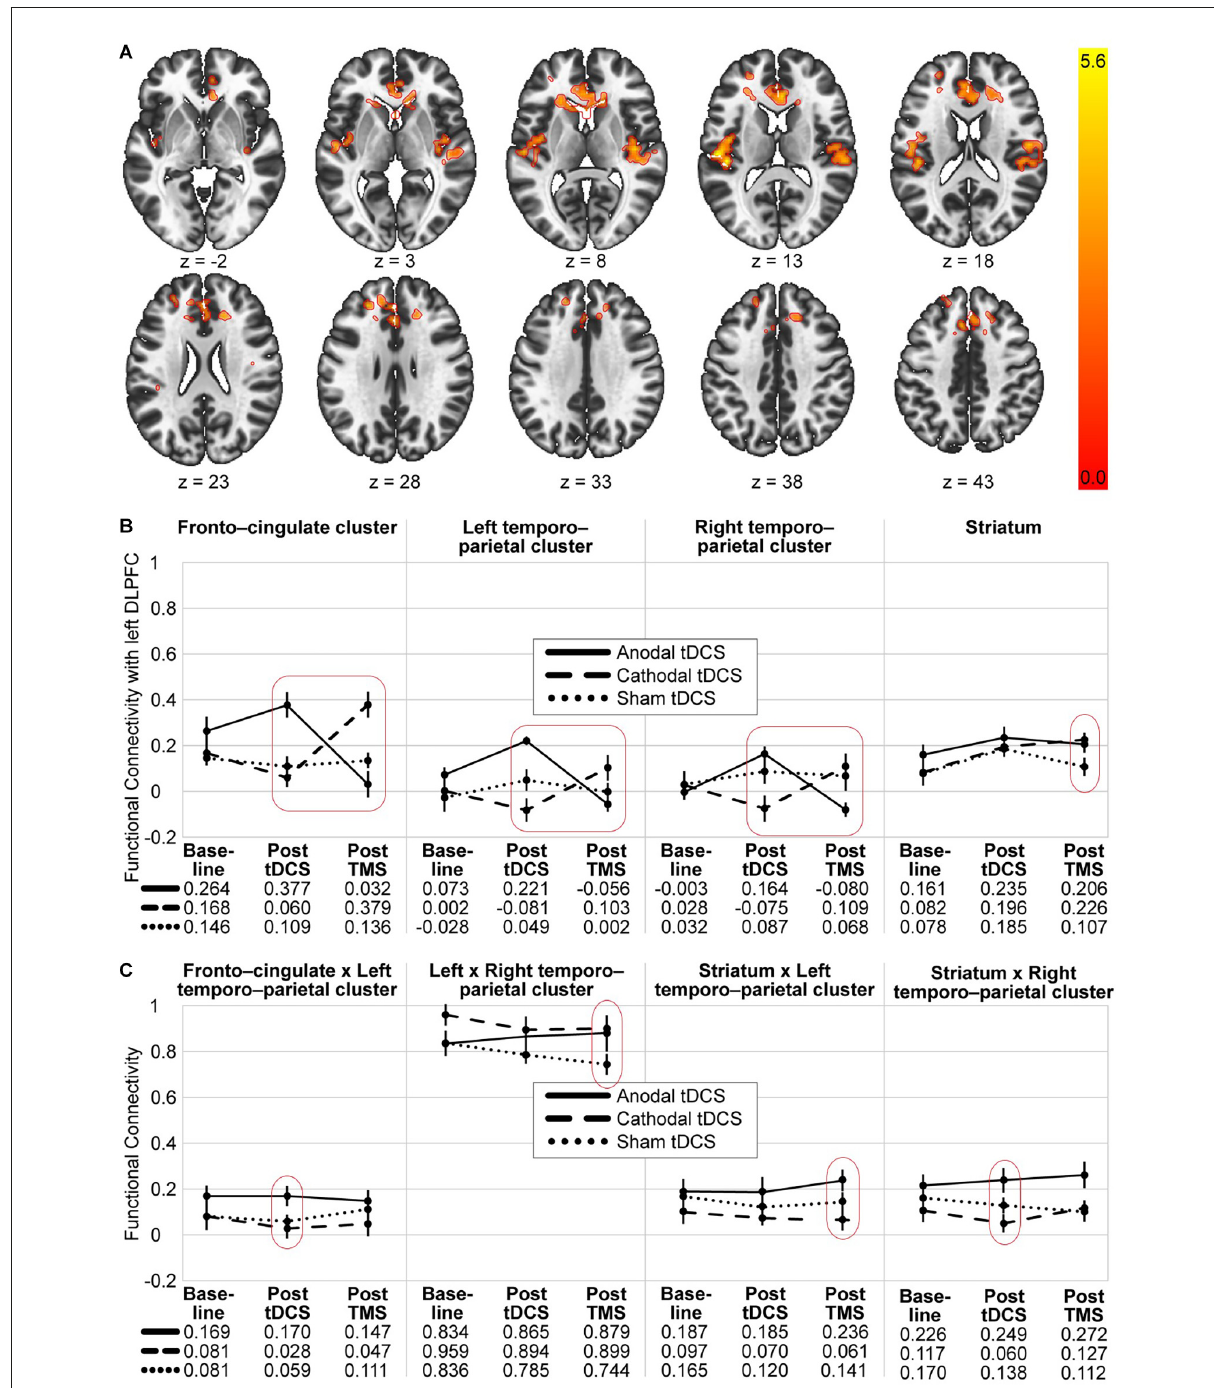
FIGURE2 Visualisation of the seed-to-voxel and ROI-to-ROI analysis results. (A) Significant voxel and cluster location for the seed-to-voxel analysis with the 2 × 2 contrast: anodal > cathodal and post tDCS > post-TMS. The coloured scale indicates T-values of significant voxels. (B) Each diagram represents the mean functional connectivity in the three groups (anodal, cathodal and sham tDCS) and three timepoints (baseline, post tDCS and post TMS) and between the stimulation site and three significant clusters and the striatum, respectively. Only the entire design, the repeated measure differences of the sham group and planned post-hoc between-group-comparisons at each of the post stimulation timepoint were tested. (C) Diagrams of mean functional connectivity values for each group and timepoint off our additional significant ROI-to-ROI connections. Significant interactions are marked with a red square and significant differences are encircled (see Tables 2 , 3 for details). Error bars represent standard errors. Anodal tDCS, solid line; cathodal tDCS, dashed line; sham tDCS, dotted